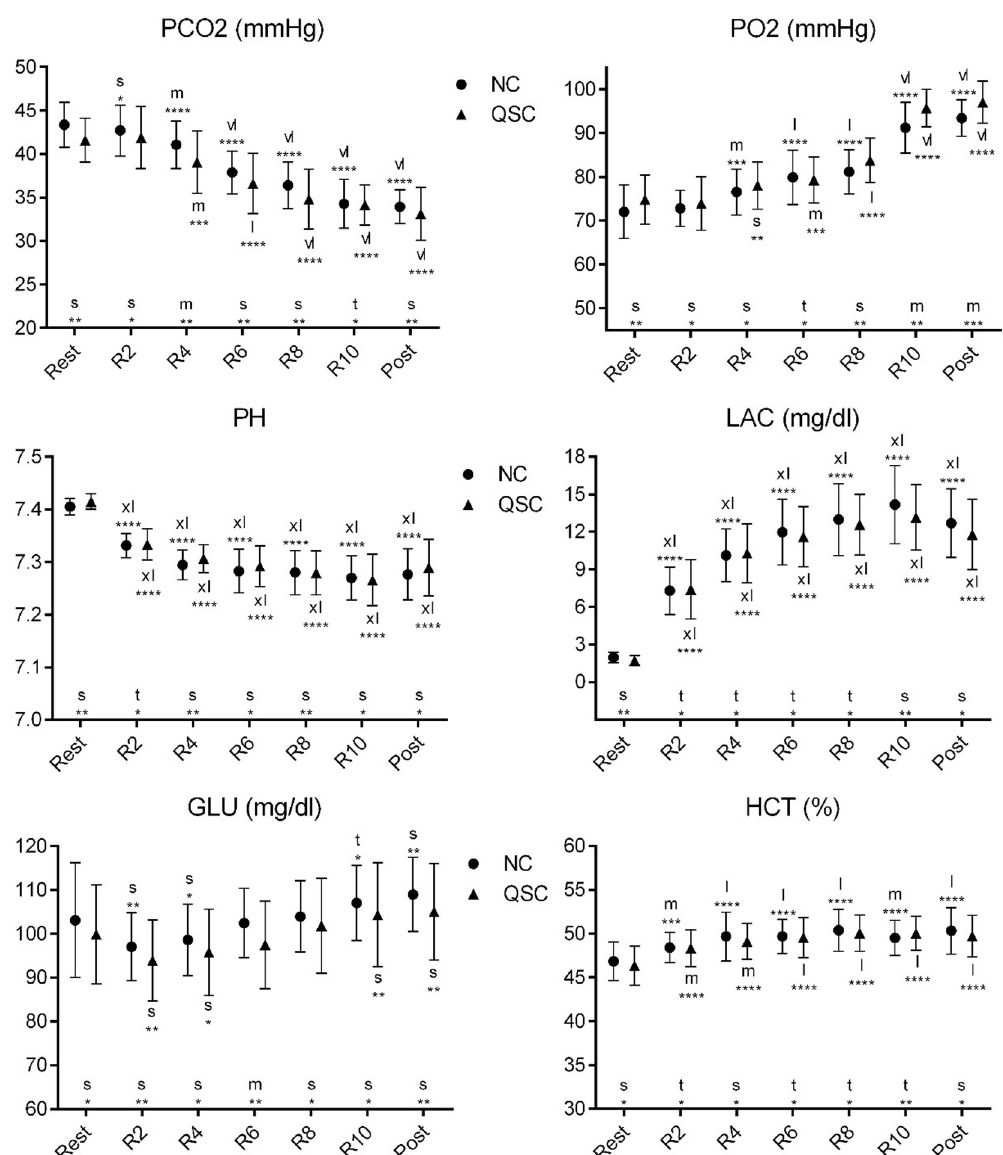
Fig 3. Change in the means of blood-related variables in each repetition in NC and QSC. Error bars are 90% compatibility intervals. Letters stand for the magnitude of the mean changes as following: t = trivial; s = small; m = moderate; l = large; vl = very large; xl = extremely large. Asterisks indicate the likelihood for the magnitude of the true effect as follows: � possible; �� likely; ��� very likely; ���� most likely. Letters and asterisks next to the x-axis indicate the magnitude and uncertainty of the mean changes from NC to the QSC. Letters and asterisks above and below the error bars indicate the magnitude and uncertainty of the mean changes from the rest status to the 2nd to 10th repetition and post-test status in NC and QSC. Effects are unclear in the situations without letters or